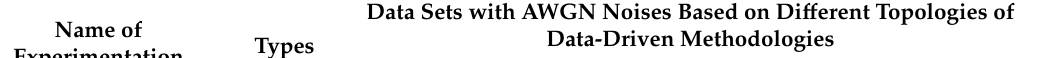
Table 6. Datasets of experimentations with AWGN noises based on di ff erent topologies of the data-driven methodologies: FFT + MPCA and FFT +